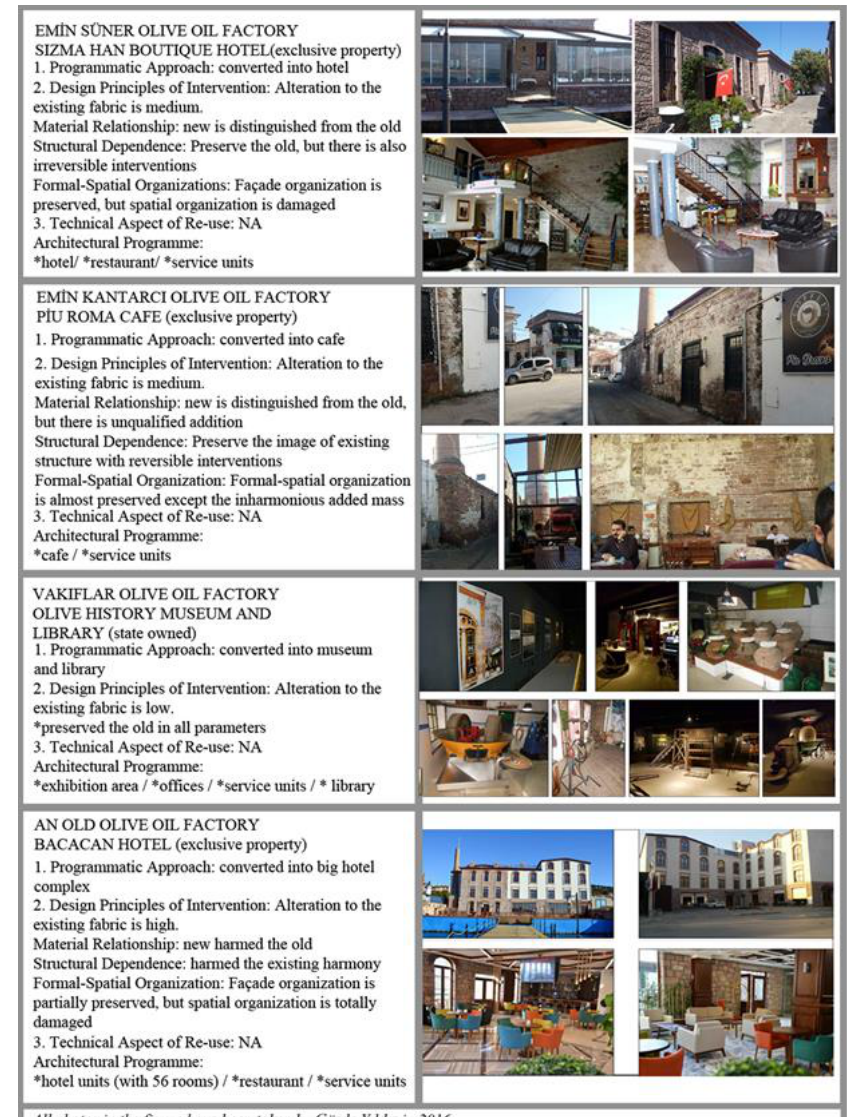
Figure 2 : Selected Ayvalık Adaptive Re-use Examples for the evaluation of the site within the scope of the